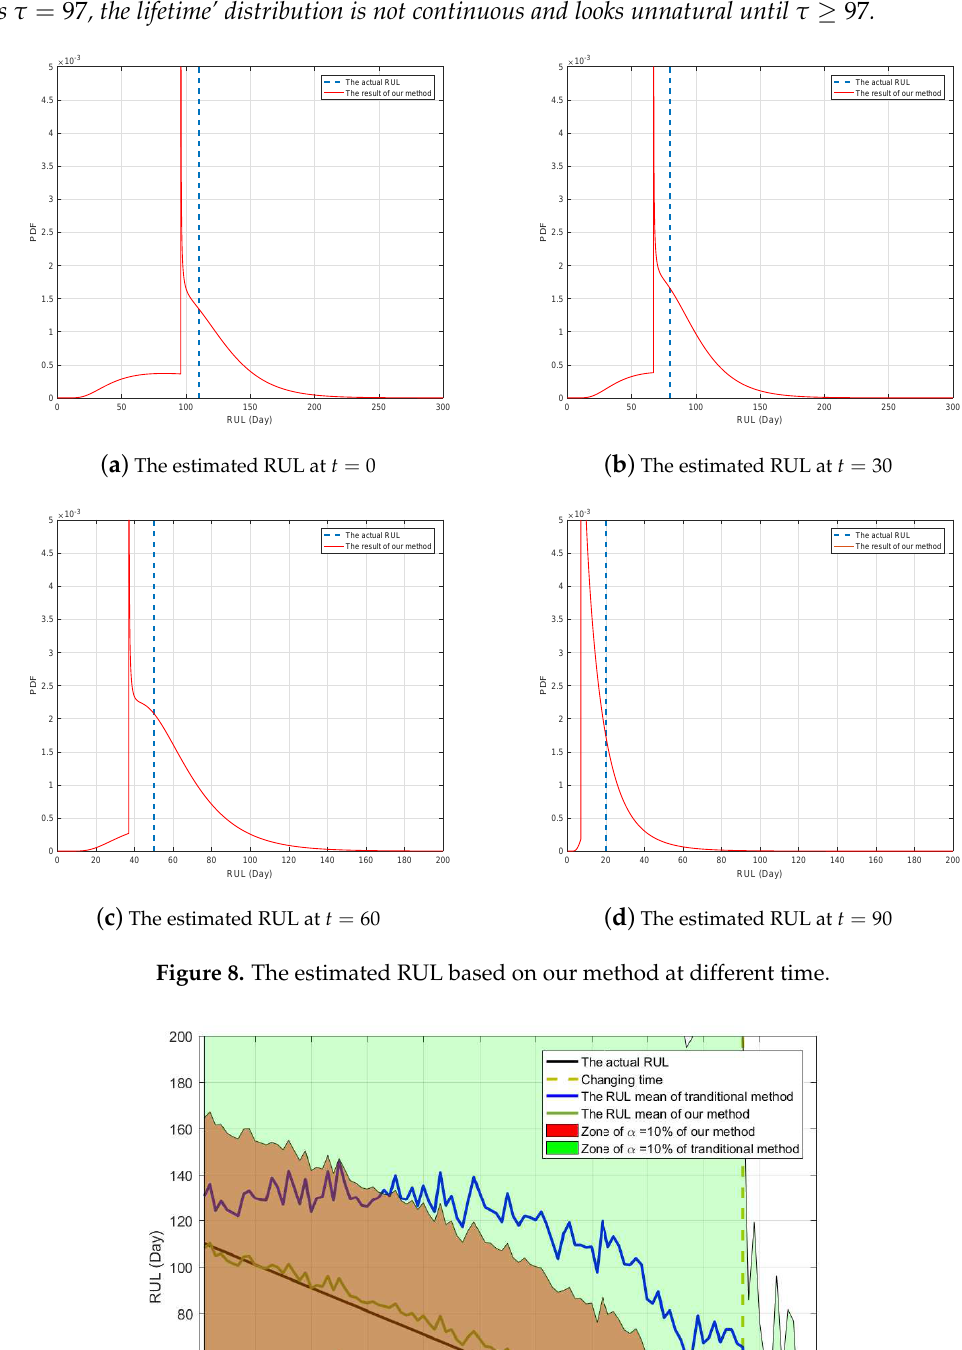
Figure 9. The comparison of estimated RUL between traditional method and our